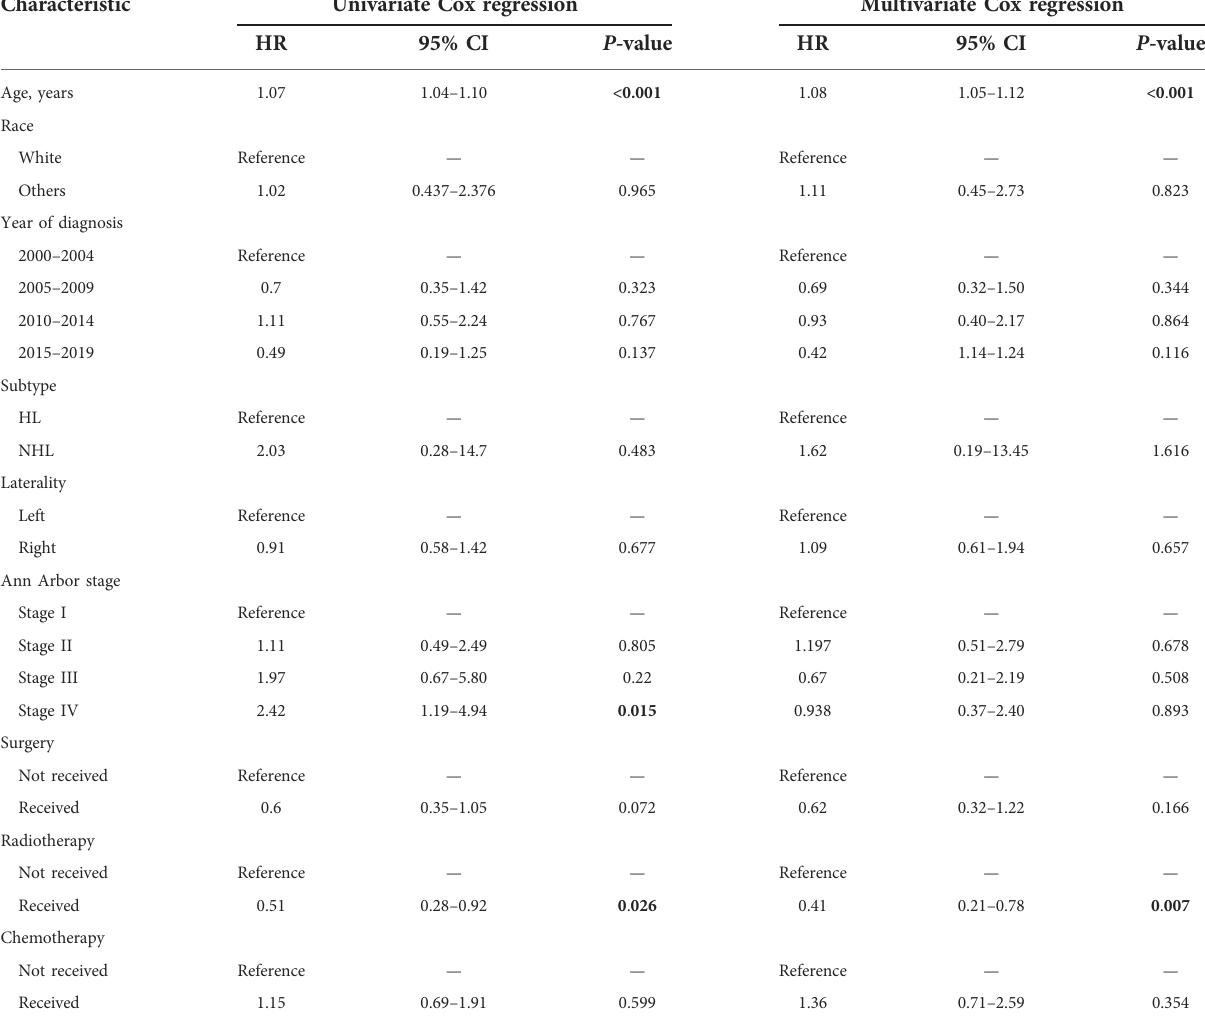
TABLE 2 Univariate and multivariate Cox hazard proportional regression results in male patients with primary breast lymphoma.